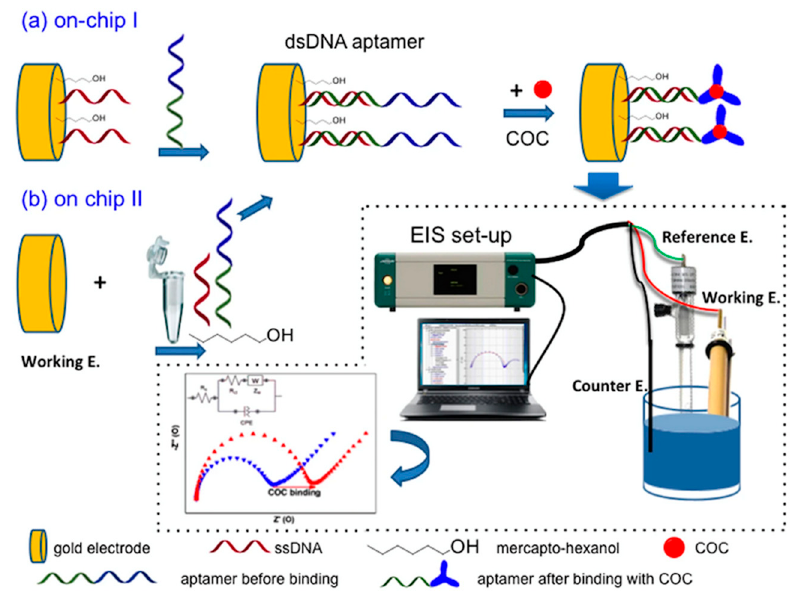
Figure 10. Schematic illustration of the DDIAS for detection of cocaine within the ‘on-chip I’ ( a ) and ‘on-chip II’ ( b ) approaches using EIS [63]. Reused from Springer Nature under the Creative Commons CC BY license.